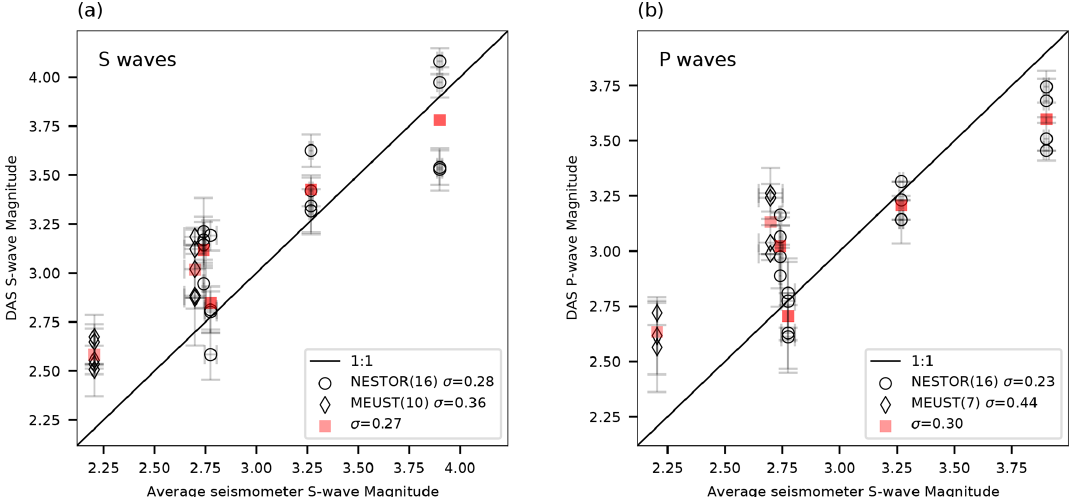
Figure 11. Comparison between DAS and seismometer magnitude estimates. Moment magnitudes estimated using DAS recorded S waves (a) and P waves (b) are plotted as a function of average magnitudes obtained using seismometer records. DAS event averaged magnitudes are plotted in red squares. The black curve is a 1 : 1 line. The number of data points and standard deviations to magnitude residuals are indicated in the legends. DAS magnitude errors are the standard deviations for magnitudes determined for each individual seismogram in the analyzed fiber segment, while seismometer errors are the standard deviations for single seismometer estimates.